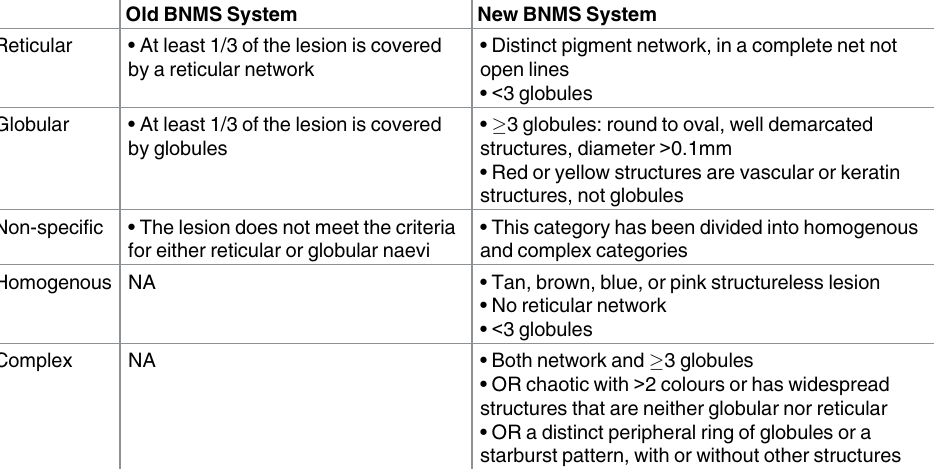
Table 1. Dermoscopic pattern criteria of the old BNMS classification systemand new BNMS classifi- cation